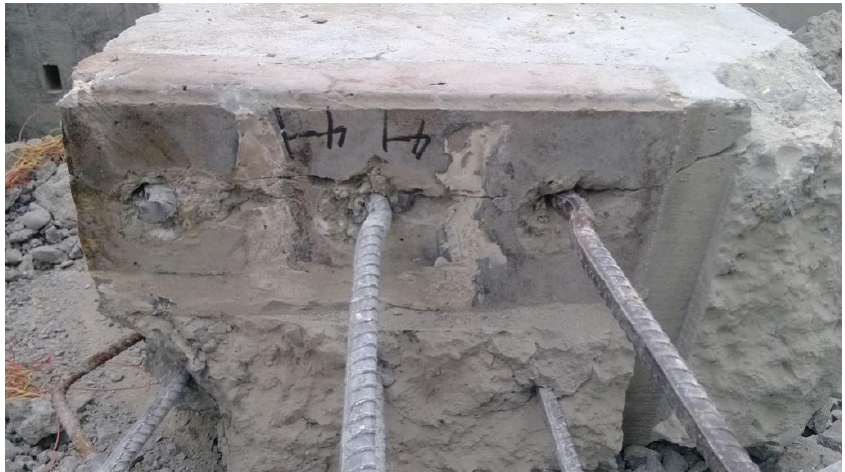
Figure 11. Concrete dowel and reinforcement of the BH 4-1 specimen after the test.